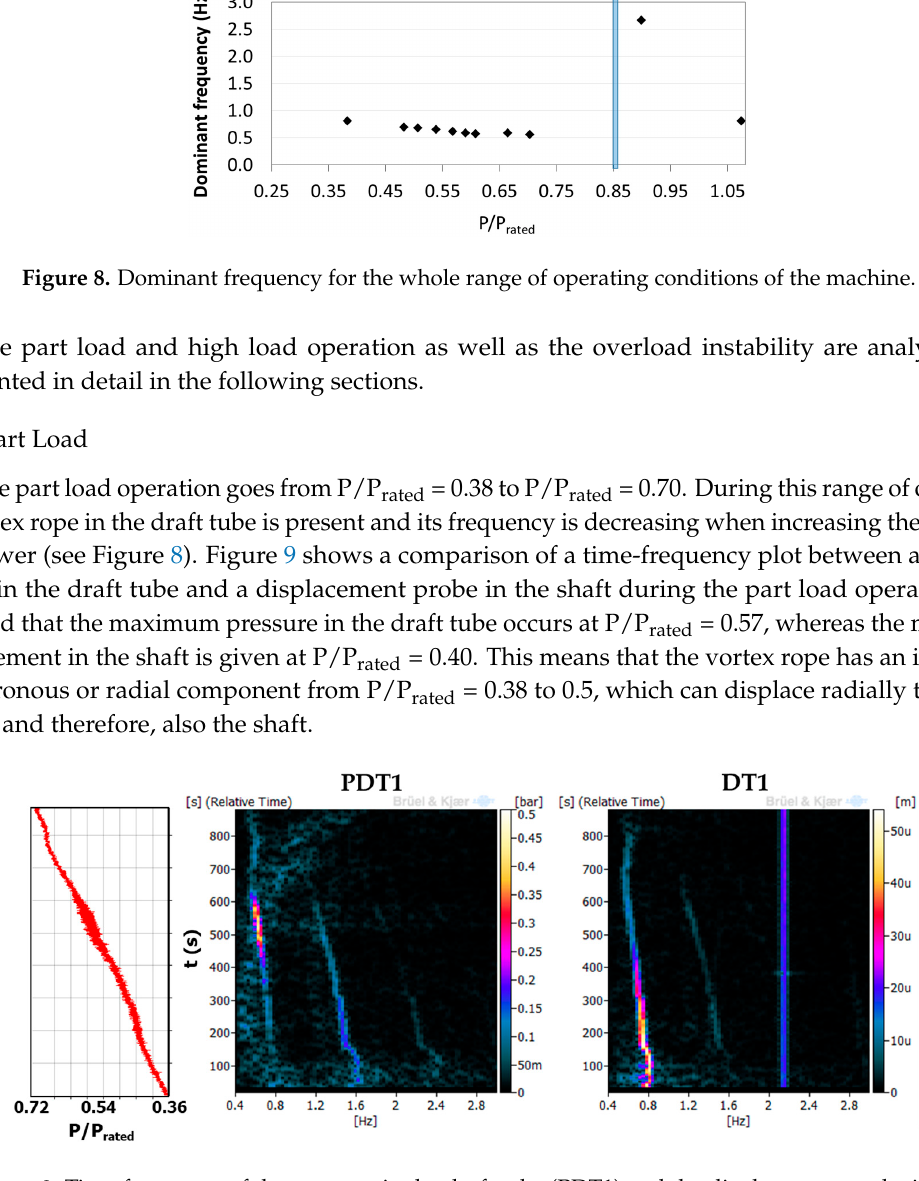
Figure 9. Time-frequency of the pressure in the draft tube (PDT1) and the displacement probe in the shaft (DT1) for the part load operation.